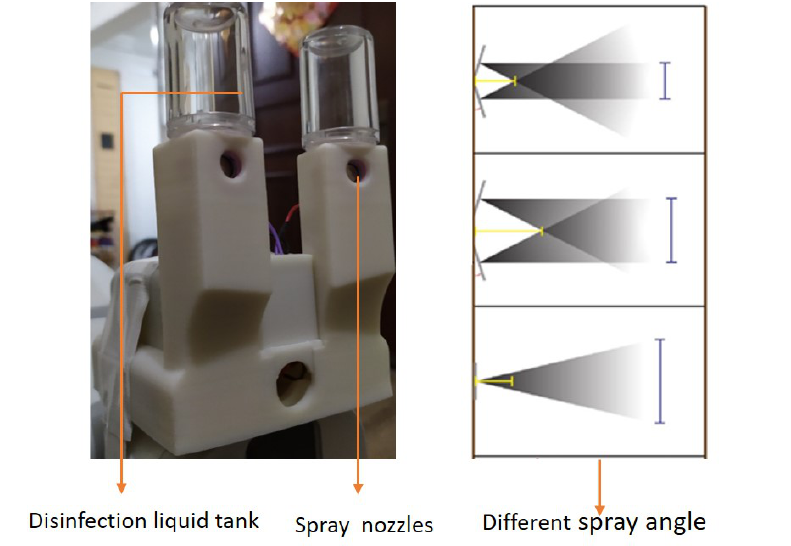
Figure 4. Disinfectant liquid spraying